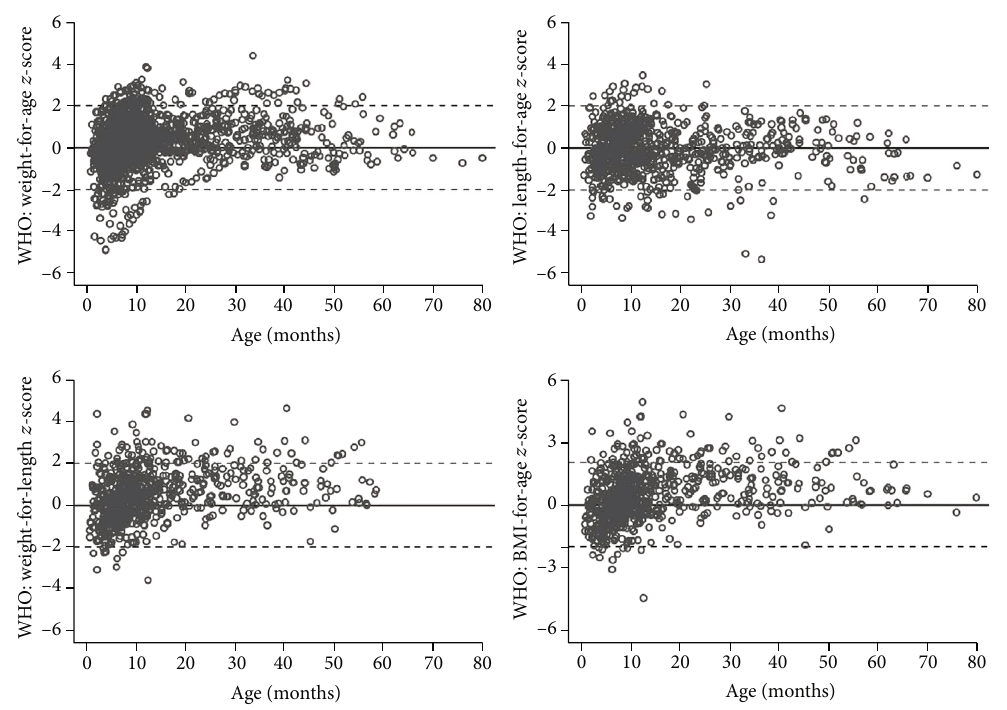
Figure 1: Treated and nontreated patients ’ z -scores compared to WHO standards.